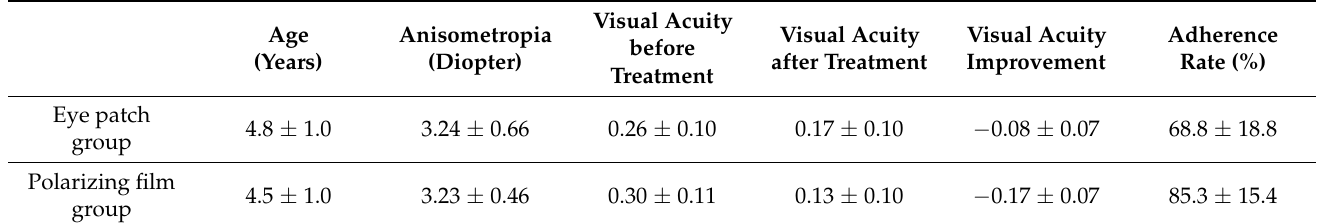
Table 1. The age, anisometropia, visual acuity before and after treatment, value of improvement in visual acuity with treatment, and compliance rate in this study are shown here. Significant differences were found in the visual acuity improvement values and compliance rates.